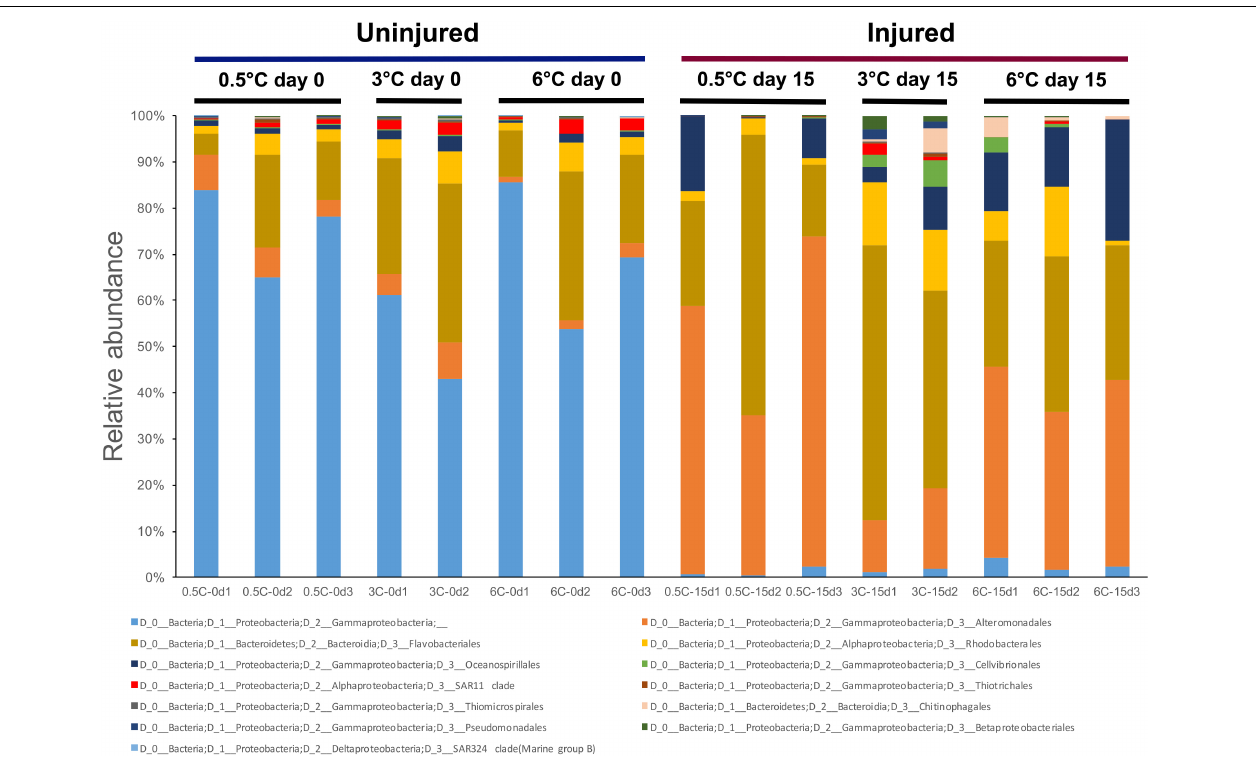
( Figure 5 ). Among these OTUs, seven OTUs were also some the most discriminant, explaining differences between treatments according to the SIMPER analysis ( Supplementary File 4 ).